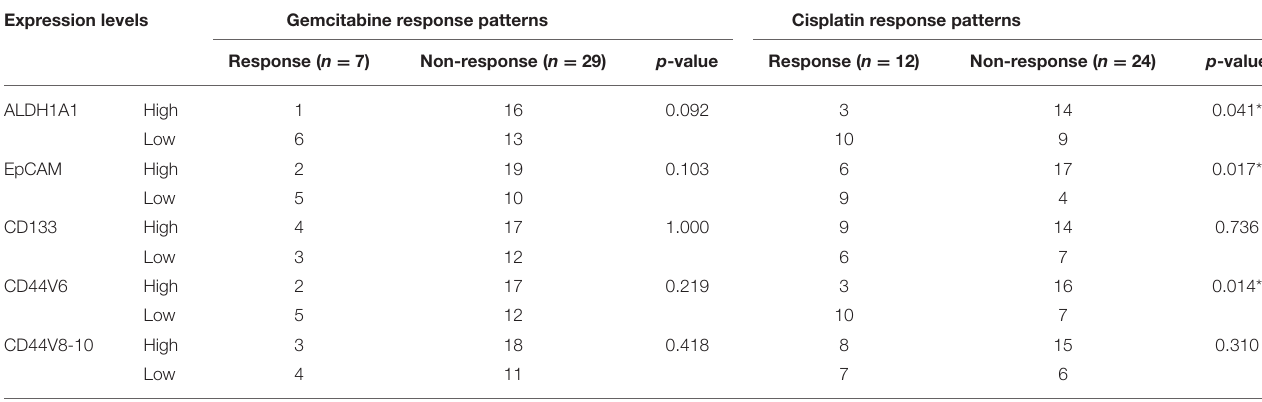
TABLE 3 | Correlation of the expression levels of cancer stem cell (CSC) markers with the gemcitabine and cisplatin response pattern from histoculture drug response assay (HDRA) results. Expression levels Gemcitabine response patterns Cisplatin response patterns Response ( n =